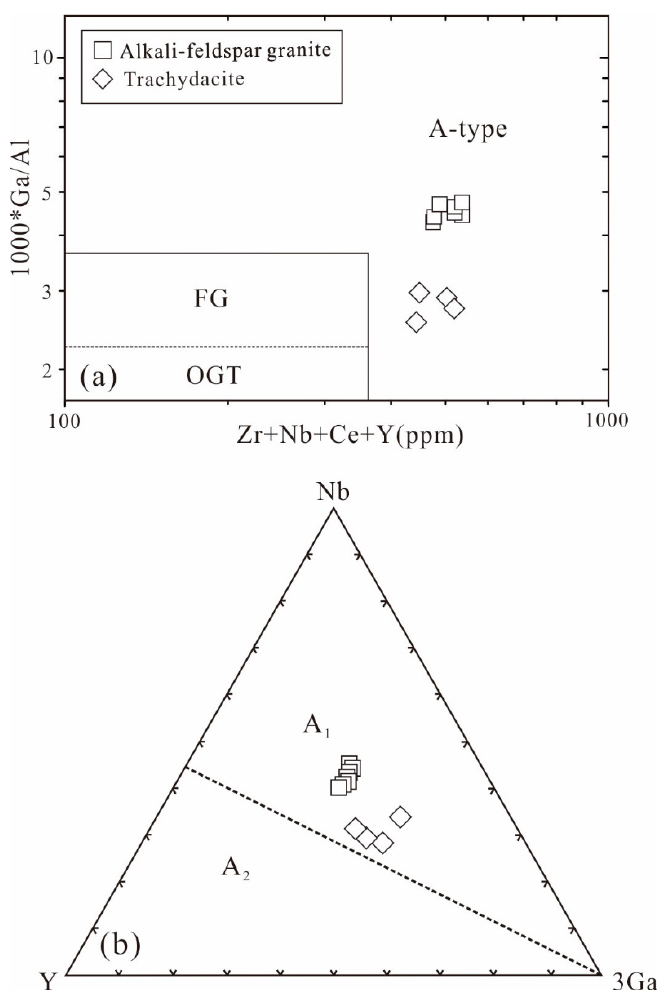
Figure 8. ( a ) Zr + Nb + Ce + Y vs. 10000*Ga / Al [34] and ( b ) representative triangular plots for distinguishing between A 1 and A 2 granitoids [9] for Tiantangshan alkali-feldspar granite.